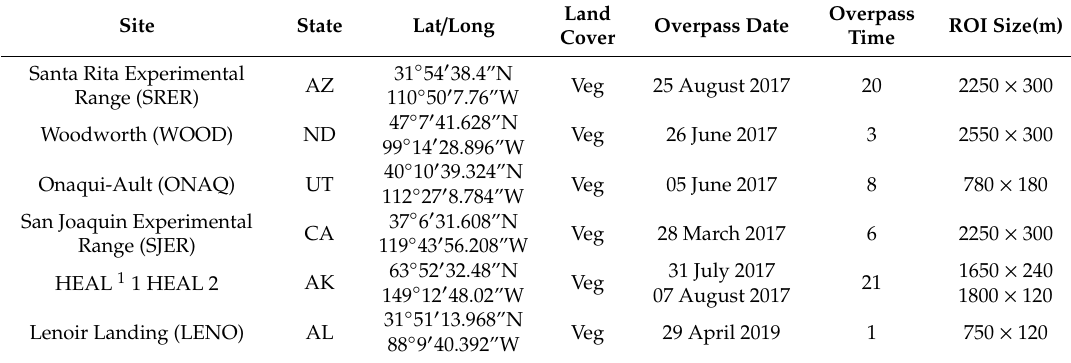
Table 3. NEON measurement sites used for OLI Level 2 surface product